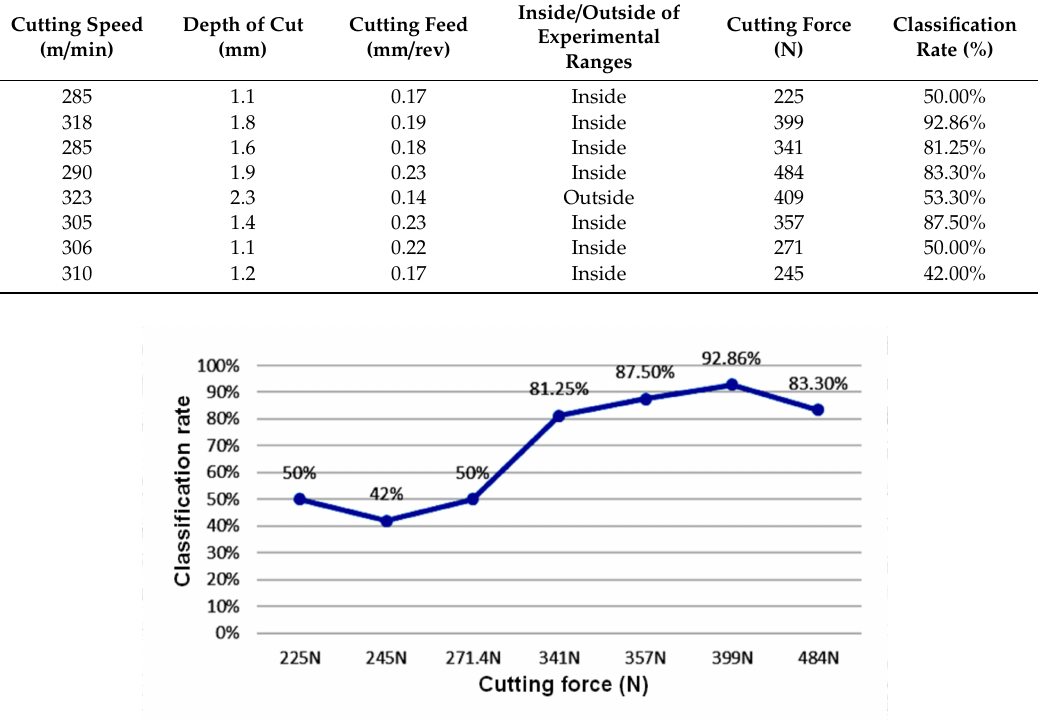
Figure 6. Relationship between cutting force and classification